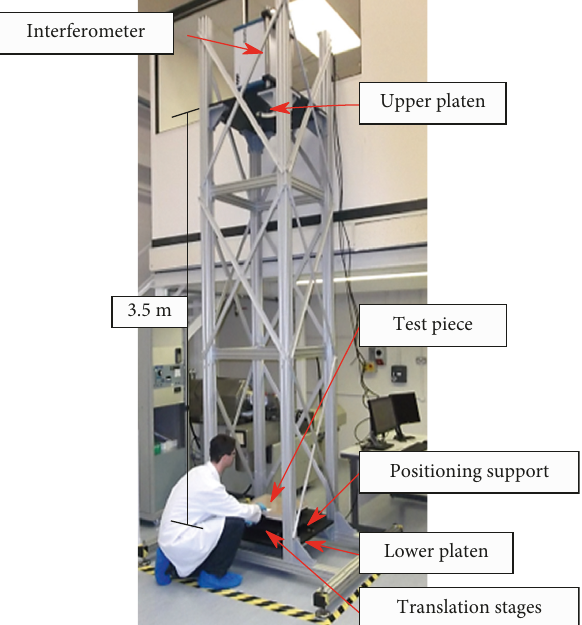
Figure 1: The OTS in the Precision Engineering Institute